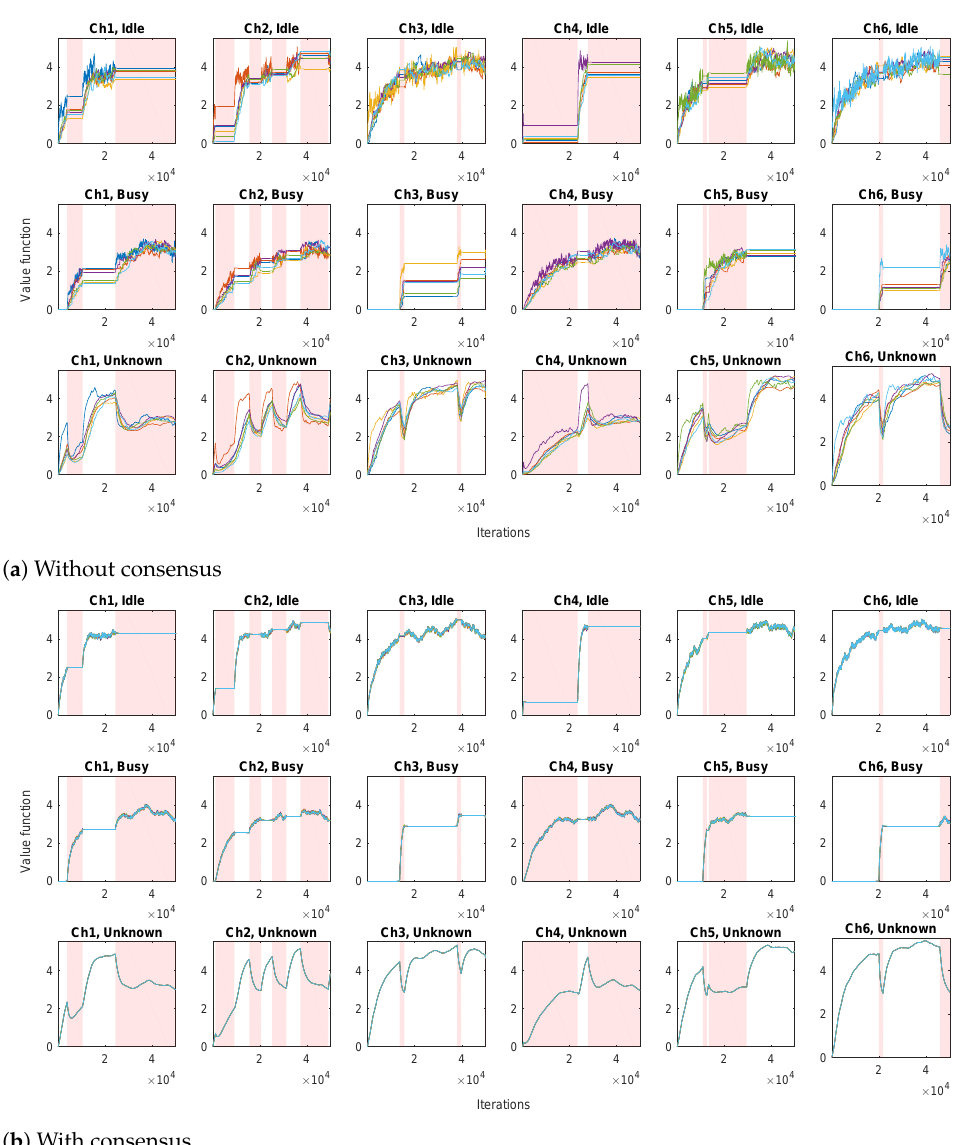
Figure 2. Value function estimations for all the states (different plots) and all the agents (different lines). Intervals during which the channels are busy are shown in shades of